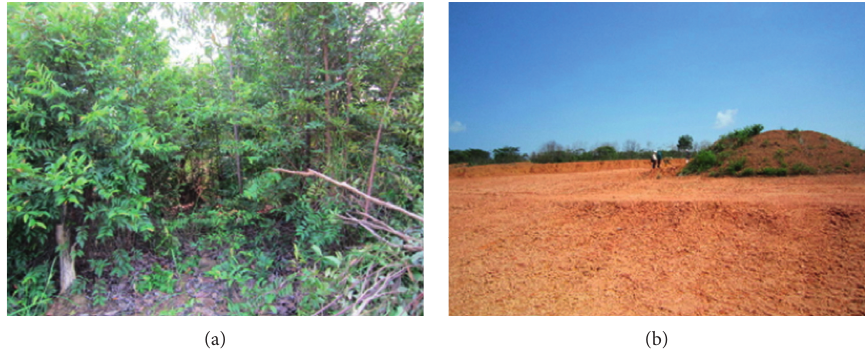
Figure 2: (a) Natural forest and (b) post-opencast bauxite mining land, Bintan Island,